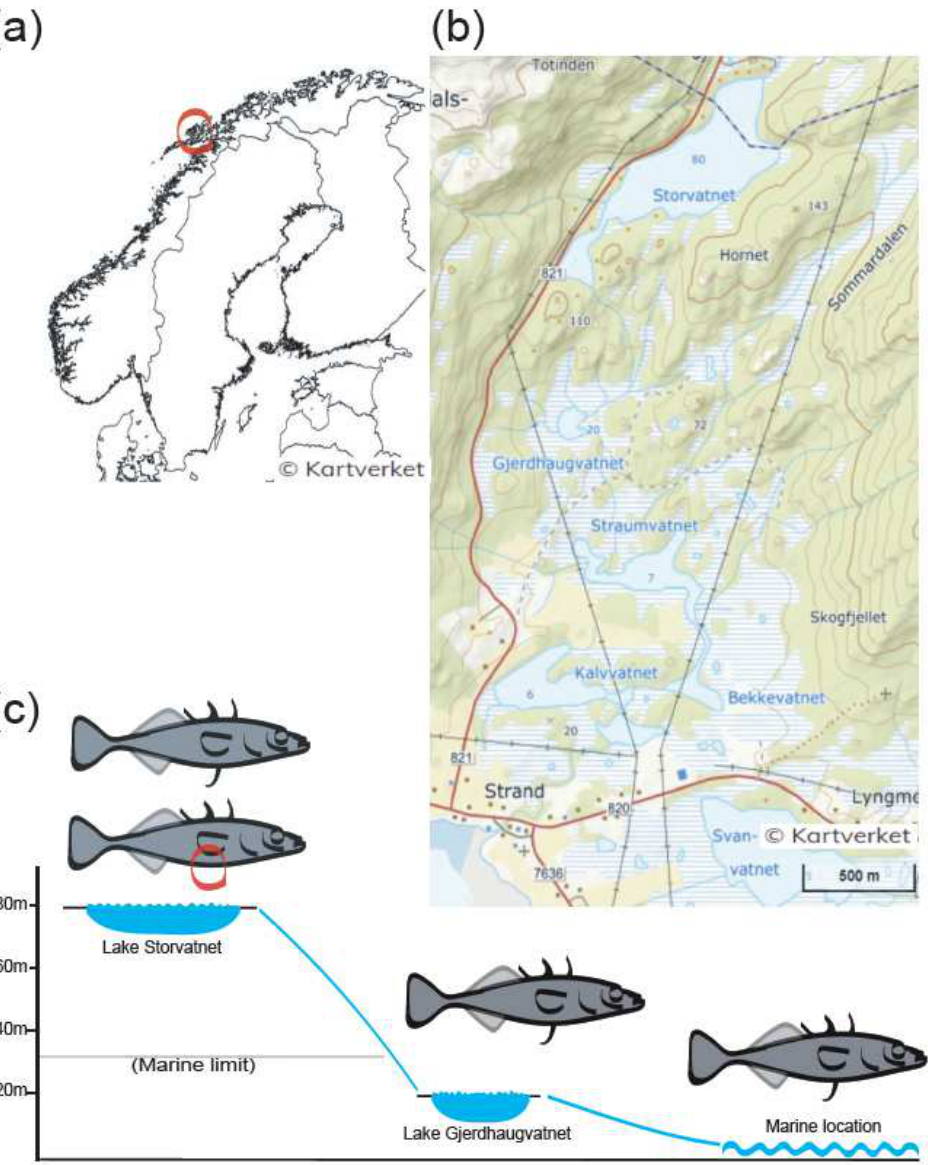
Figure 2. ( a ) Scandinavia with the study site encircled in red. ( b ) Map (www.norgeskart.no accessed on 28 March 2023) of the upper Lake Storvatnet (68°46′49″ N, 15°9′36″ E) and the lower Lake Gjerdhaugvatnet in the watercourse, whereas the marine sampling site (not shown) is located about 8 km from the two lakes. ( c ) Schematic drawing (out of scale) of the three sites showing the symmetric- spined, asymmetric-spined, and the spineless (encircled in red) sticklebacks in Lake Storvatnet. All specimens are symmetric spined at the two other